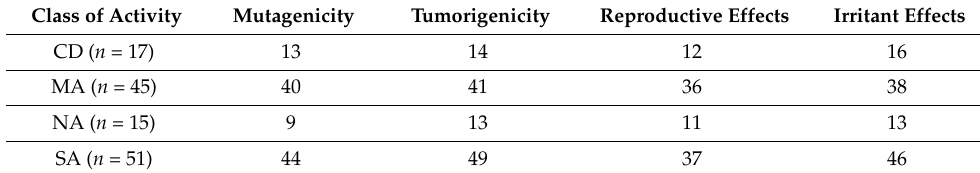
Table 3. Summary of the estimated AMNPs and CDs with negligible or no undesired